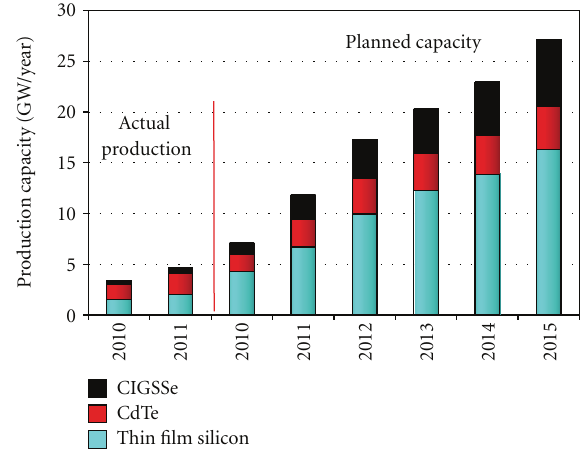
Figure 6: Actual production and planned capacities of the di ff erent thin film